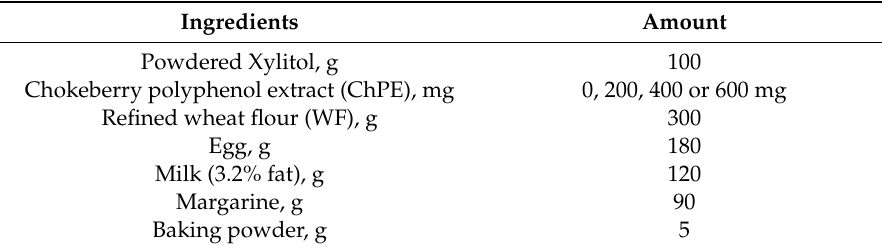
Table 1. Mu ffi n